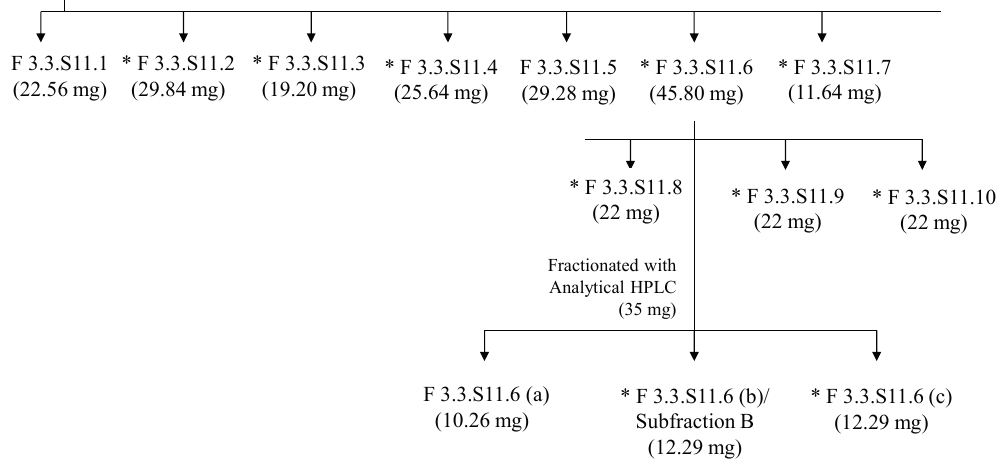
Figure 6. Fractionation and isolation scheme for Melastoma malabathricum Linn. leaf hot water crude